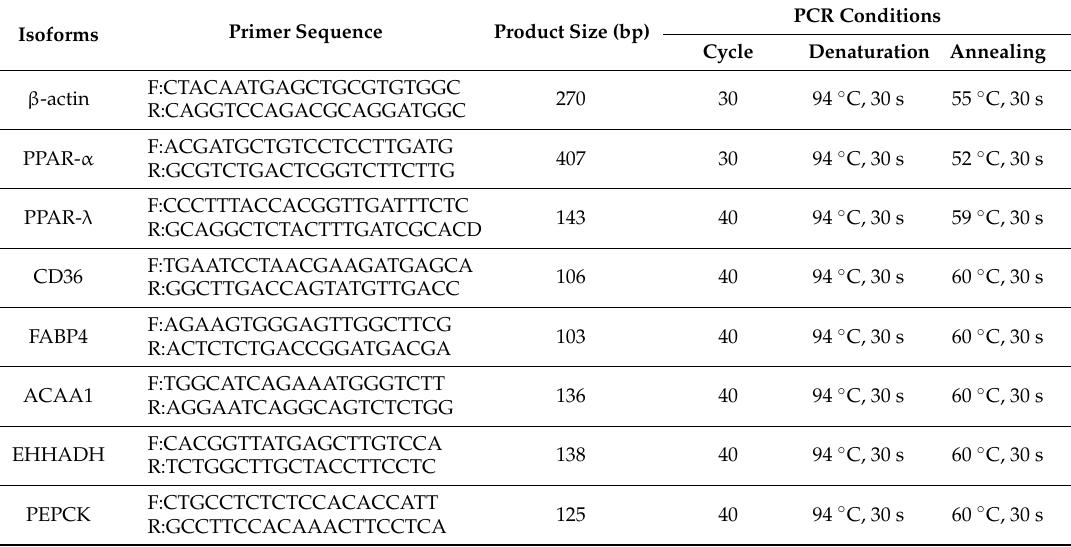
Table 4. Sequences of primers used for RT-PCR analysis and PCR conditions.